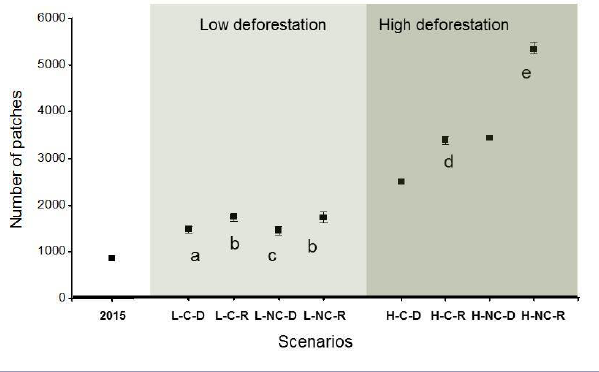
Fig. 5. Mean (min/max) number of patches in simulated scenarios. Scenarios differ in deforestation rate (L: low, H: high), spatial planning at the regional level (C: with corridors, NC: without corridors) and spatial planning at the plot level (D: design, R: random). Different letters inside the panel represent significant differences ( p < 0.05, see Appendix